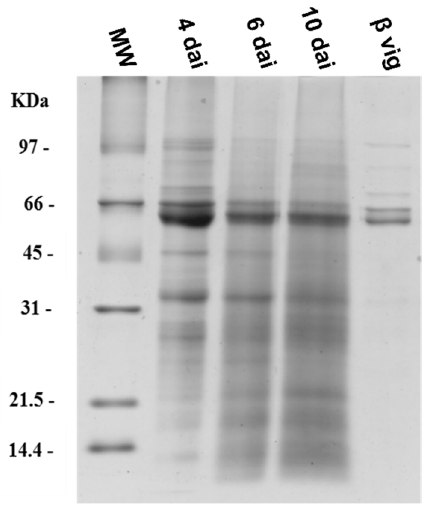
Figure 6. SDS-PAGE of the germinating cowpea extracts obtained after 4, 6, and 10 d.a.i. β-vig: pu- rified β-vignin reference sample. dai.: days after imbibition.